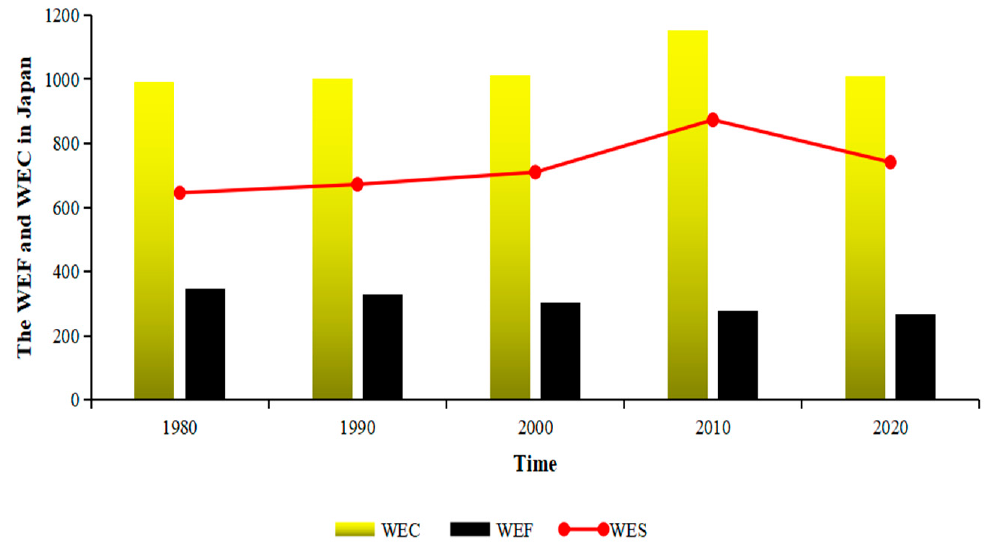
Figure 7. Changes of the WEF and WEC in Japan from 1980 to 2020 (Unit: 1 M gha). Table 2. The total WEF and WES in Japan from 1980–2020 (Unit: 1 M gha).